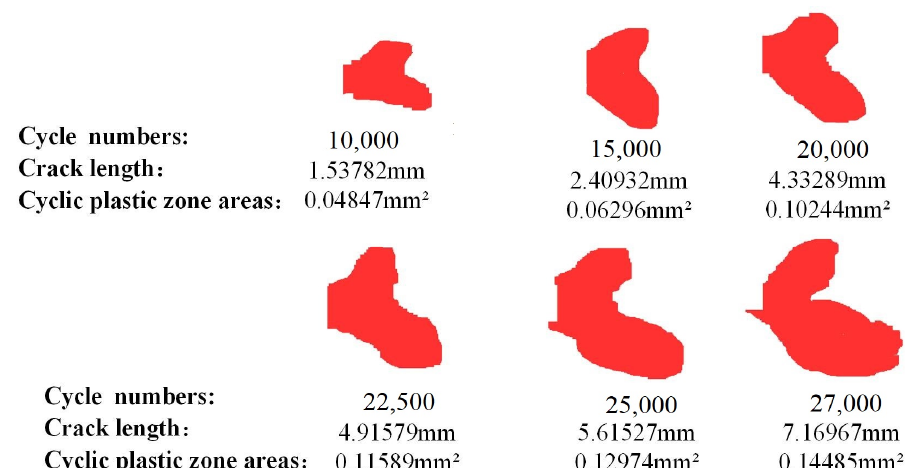
Figure 18. Shape and area of the CPZ under different crack lengths.